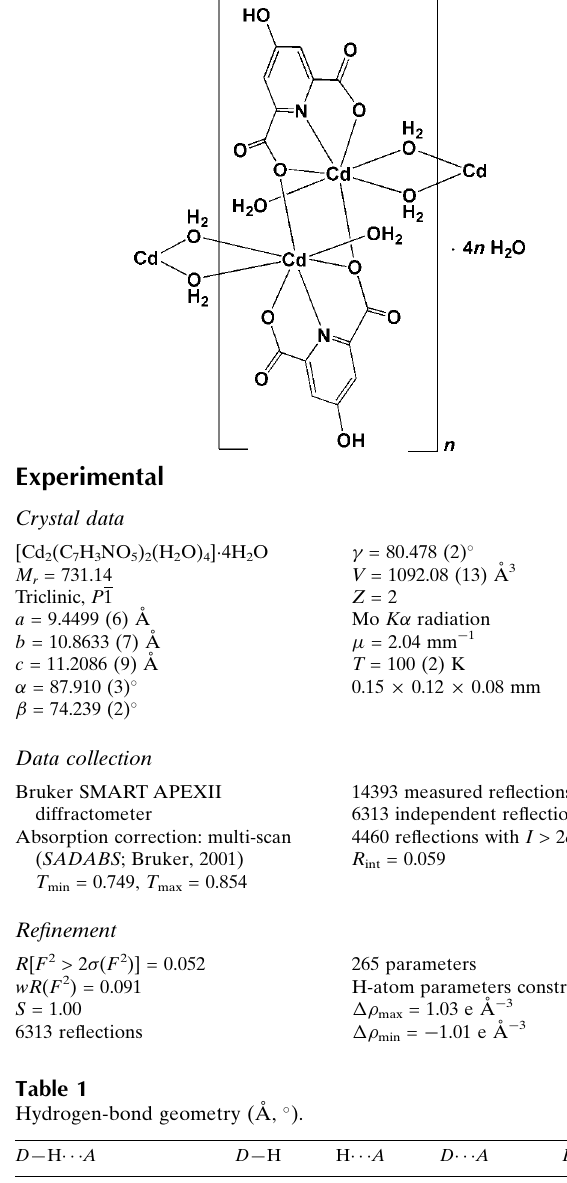
Hydrogen-bond geometry (A˚ , (cid:3) ). D —H (cid:1)(cid:1)(cid:1)